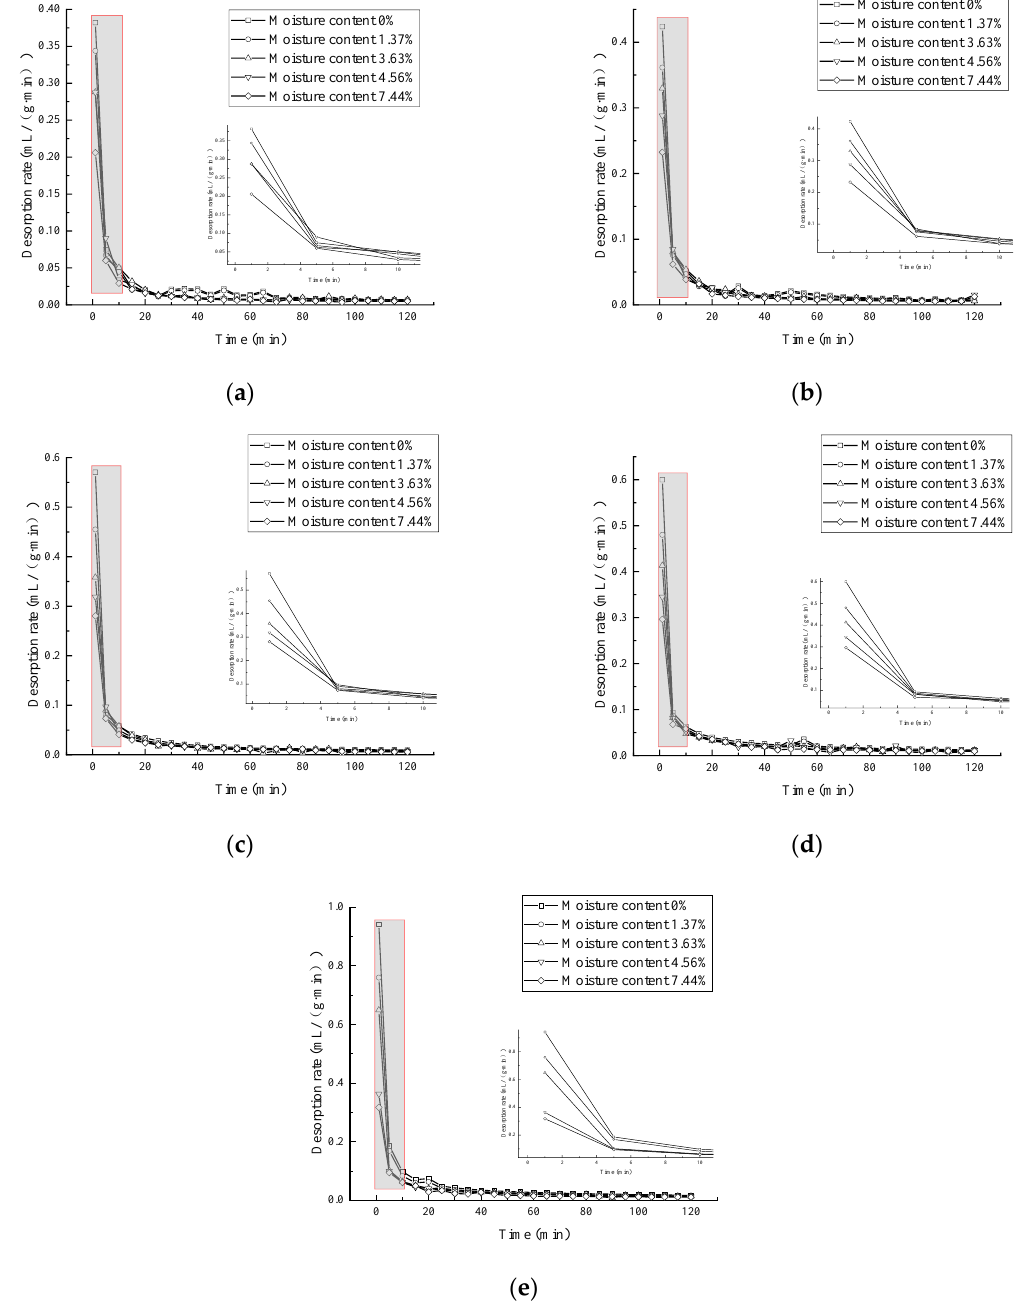
Figure 6. With unequal water content, each pressure reduction and unequal gas absorption rate at the suction stage is shown. ( a ) Desorption stage: 2.5 MPa–2 MPa. ( b ) Desorption stage: 2 MPa–1.5 MPa. ( c ) Desorption stage: 1.5 MPa–1 MPa. ( d ) Desorption stage: 1 MPa–0.5 MPa. ( e ) Desorption stage: 0.5 MPa–0 Pa.